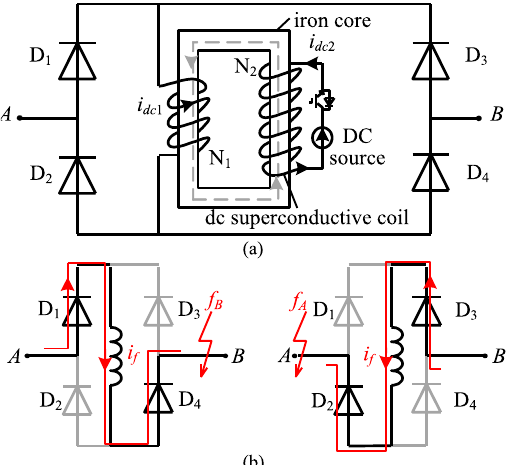
Figure 14. The working principle of the inductive SFCL: ( a ) Topology; ( b ) Short circuit current path. Fig. 1. Structure of the improved inductive SFCL.